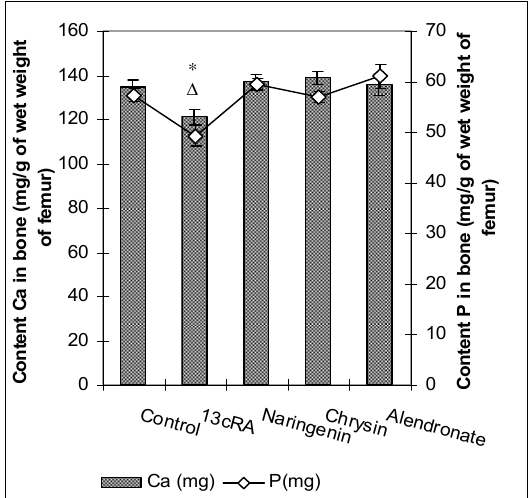
Figure 4. Effects of naringenin, chrysin, or alendronate on the levels of calcium (Ca) and phosphorus (P) in the rats with retinoic-acid-induced osteoporosis. Rats were administered ig with retinoic acid (13cRA) suspension (80 mg/kg) once daily for 14 days. After inducing osteoporosis with 13cRA, rats were administered ig with naringenin (100 mg/kg), chrysin (100 mg/kg), or alendronate (40 mg/kg), once daily for the next 14 days. Results are expressed as mg of calcium (Ca) and phosphorus (P) per gram of wet weight of right femurs. Results are expressed as means of seven samples per group ( n = 7) ± SEM. Data were analysed by the Kruskal–Wallis test. *—Statistically significant difference in calcium levels compared with all experimental groups (* p < 0.05). Δ —Statistically significant difference in phosphorus levels compared with all experimental groups ( Δ p < 0.05).